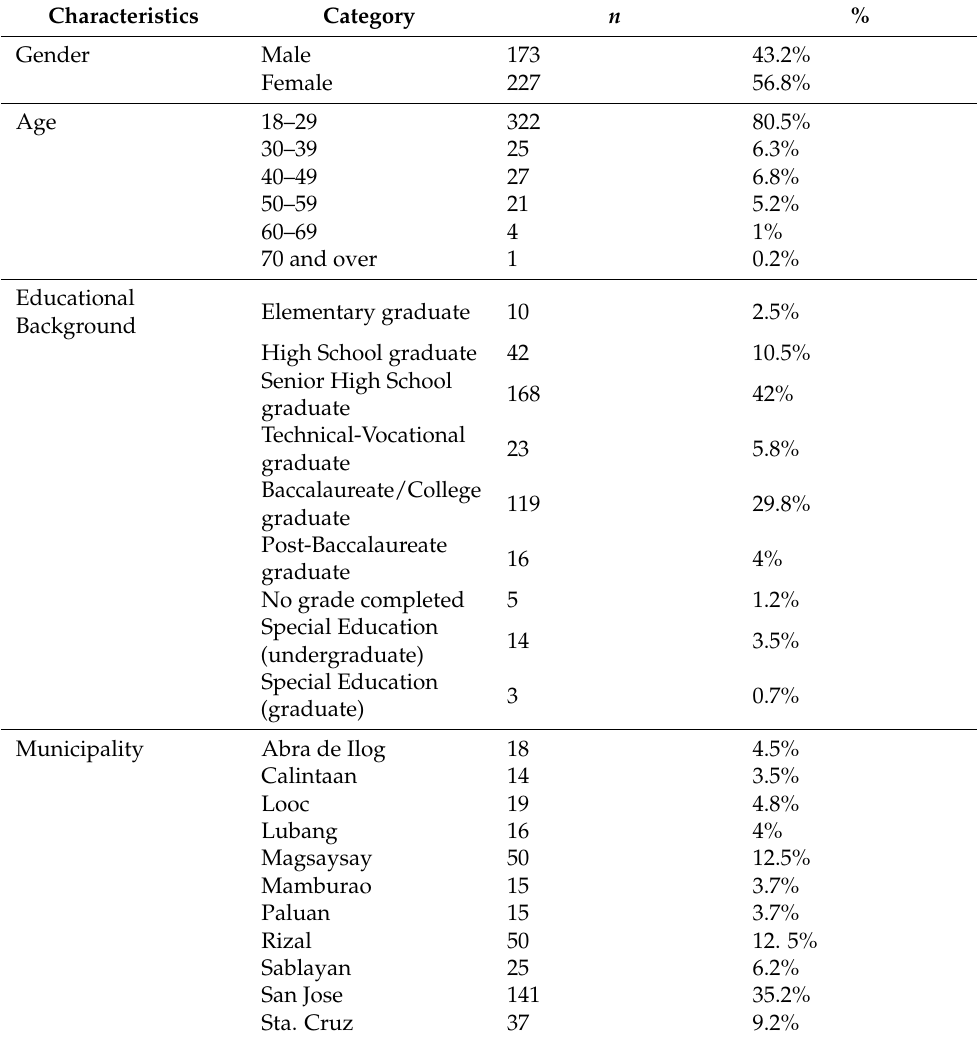
Table 1. Demographic summary of the participants ( n =